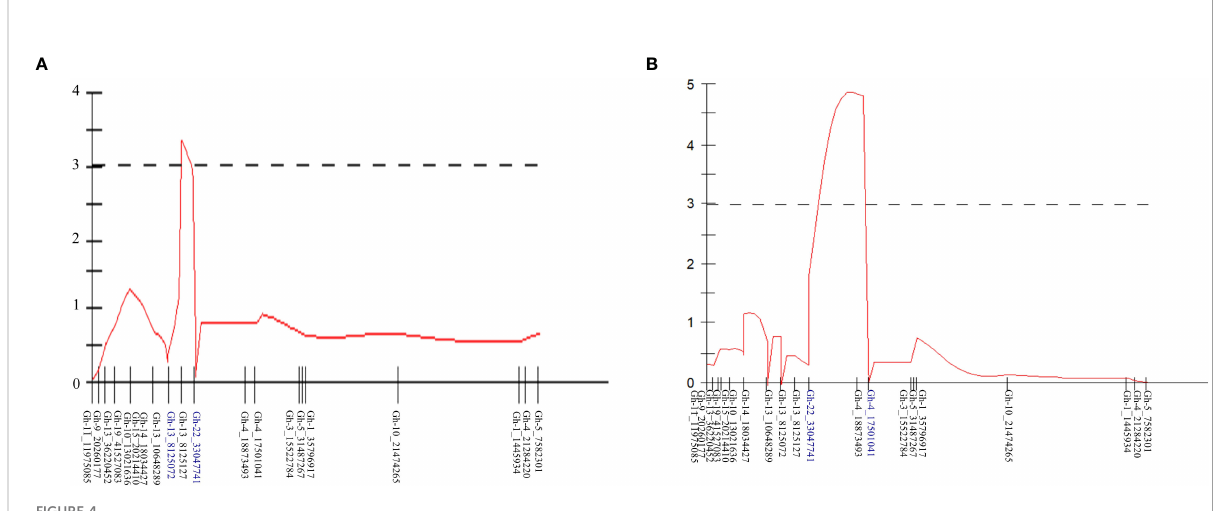
FIGURE 4 QTLs for powdery mildew (PM) resistance identi fi ed in (A) 2018 and (B) 2019 using the phenotypic PM scores and linkage map developed using F 1 segregating mapping population by crossing Gerbera breeding lines UFGE 4033 (resistant to PM) and o6-245-03 (susceptible to